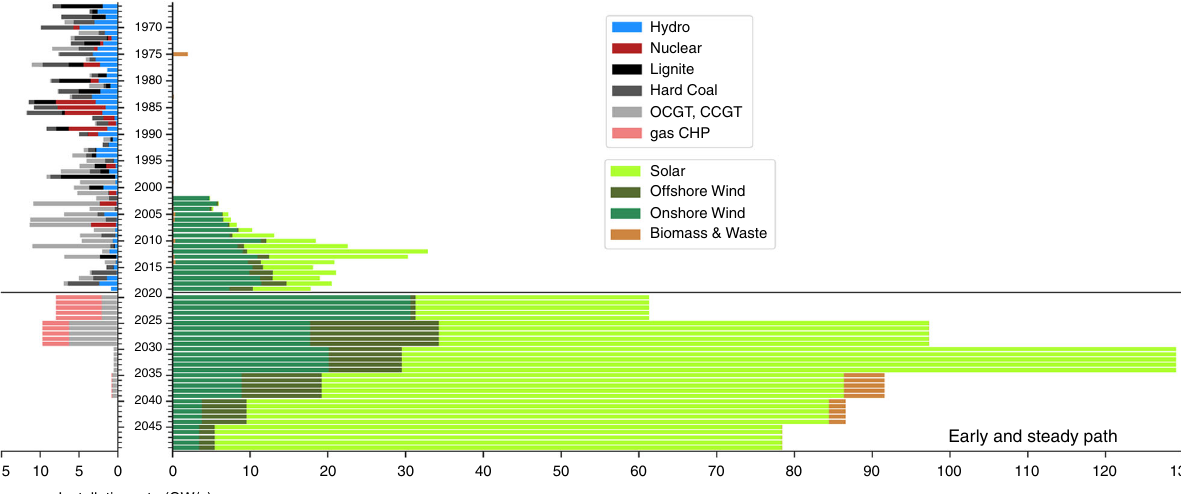
Fig. 3 Age distribution of European power plants in operation and required annual installation throughout the Early and Steady path. Historical data from refs. 53,67 , see also Supplementary Figs. 5 – 10.